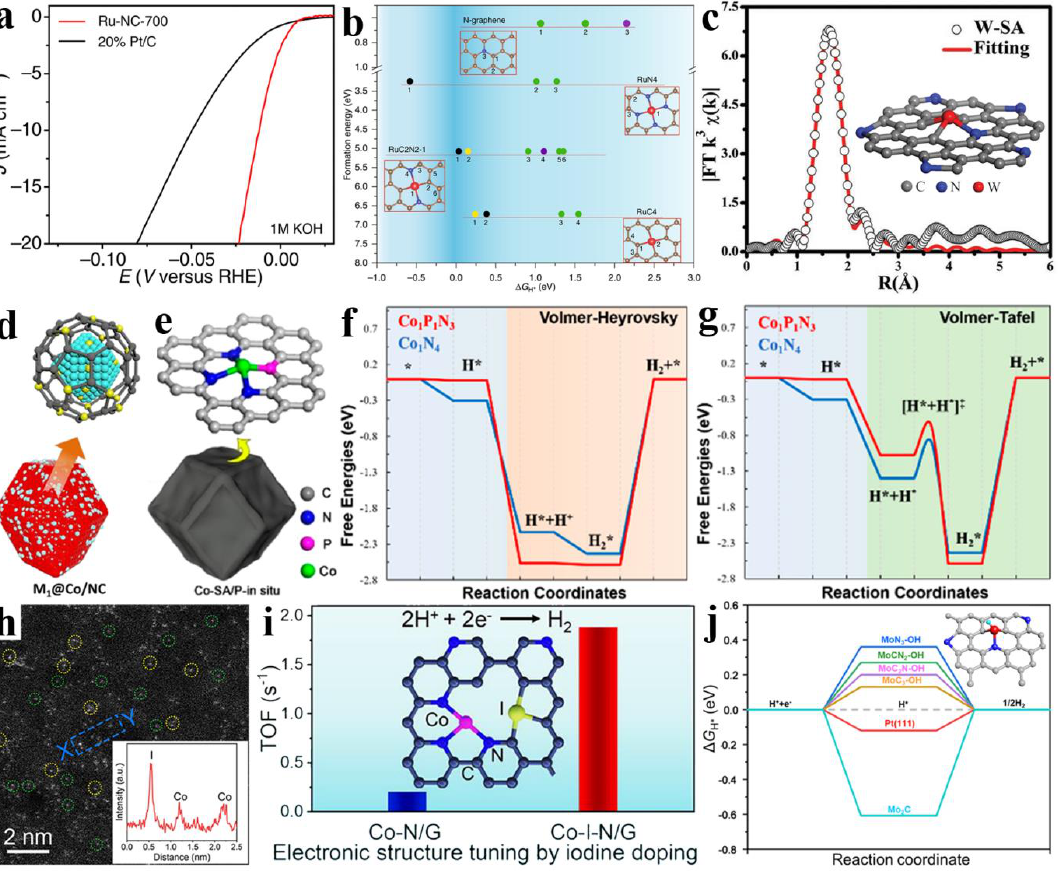
Figure 3. ( a ) LSV curves. ( b ) Free energy diagram of the different RuC x N y structures.